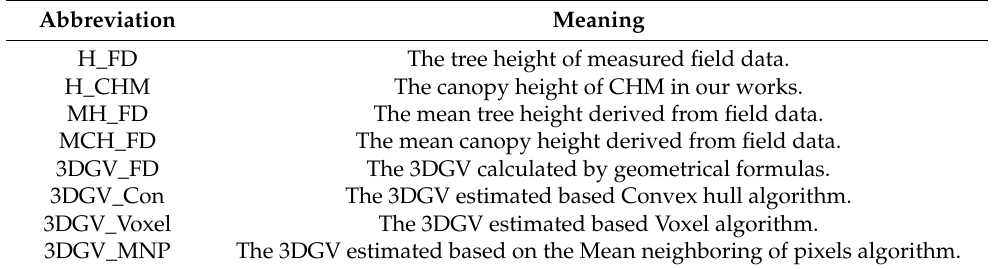
Table 1. Abbreviations of factors in this paper.